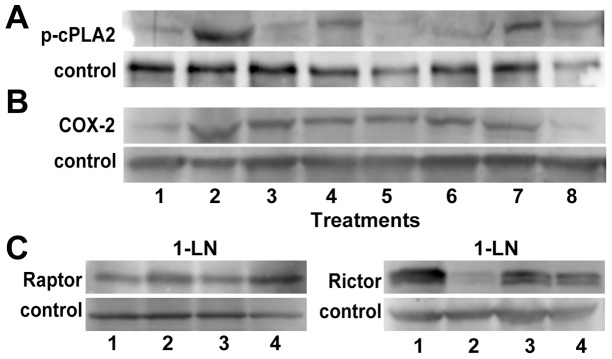
Effect of RNAi silencing of Raptor or Rictor gene expression on 8-CPT-2Me-cAMP-induced increased expression of p-cPLA2 (Panel A) and COX-2 (Panel B) in 1-LN prostate cancer cells.– A representative immunoblot of p-cPLA2 (Panel A) and COX-2 (Panel B) from four experiments is shown. The lanes in the immunoblot in Panel A are: (1) lipofectamine + buffer; (2) lipofectamine +8-CPT-2Me-cAMP (100 μM/30 min); (3) dsRaptor RNA (100 nM/48 h) then 8-CPT-2Me-cAMP (100 μM/30 min); (4) dsRictor RNA (100 nM/48 h) then 8-CPT-2Me-cAMP (100 μM/30 min); (5) Rictor dsRNA (100 nM/48 h); (6) Torin (250 nM/3 h); (7) scrambled dsRNA (100 nM/48 h) then 8-CPT-2Me-cAMP (100 μM/30 min); and (8) Torin (250 nM/3 h) then 8-CPT-2Me-cAMP (100 μM/30 min). The lanes in the immunoblot in Panel B are: (1) lipofectamine + buffer; (2) lipofectamine +8-CPT-2Me-cAMP (100 μM/30 min); (3) Raptor dsRNA (100 nM/48 h); (4) Raptor dsRNA (100 nM/48 h) then 8-CPT-2Me-cAMP (100 μM/30 min); (5) Rictor dsRNA (100 nM/48 h) then 8-CPT-2Me-cAMP (100 μM/30 min); (6) Rictor dsRNA (100 nM/48 h); (7) scrambled dsRNA (100 nM/48 h) then 8-CPT-2Me-cAMP (100 μM/30 min); and (8) Torin1 (250 nM/3 h) then 8-CPT-2Me-cAMP (100 μM/30 min). The control is cPLA2 in Panel A and actin in Panel B. Also shown in Panel C are Raptor and Rictor protein levels in 1-LN cells transfected with Raptor dsRNA orRictor dsRNA. The lanes are as in Figure 7.